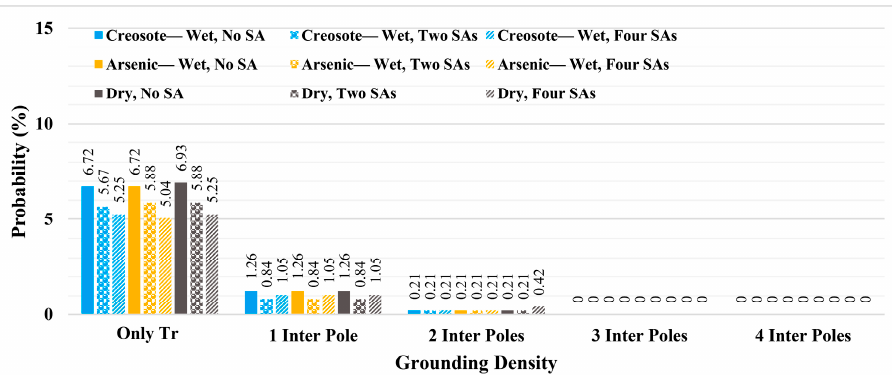
Figure 27. Comparison among the probabilities of transformers experiencing overvoltage stress above 150 kV under different grounding densities of intermediate poles (Inter Pole) and considering two and four surge arresters (SAs); Network with dry